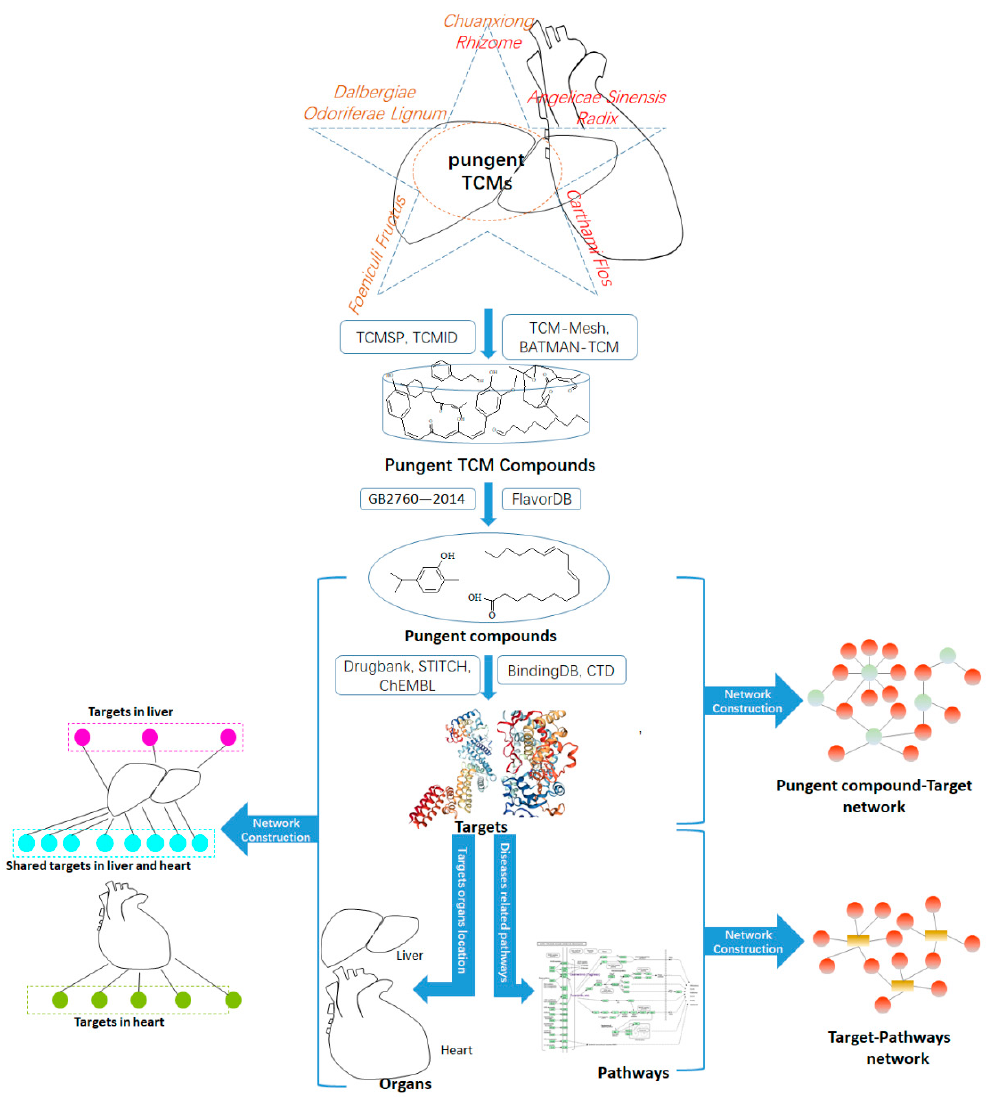
Figure 7. The workflow to study the relationship between pungent flavored compounds and their special targets organ location in the cardiovascular system. The cyan circle represents the shared target in liver and heart. The magenta circle represent the targets in liver. The yellowish green circle represents the target in heart.